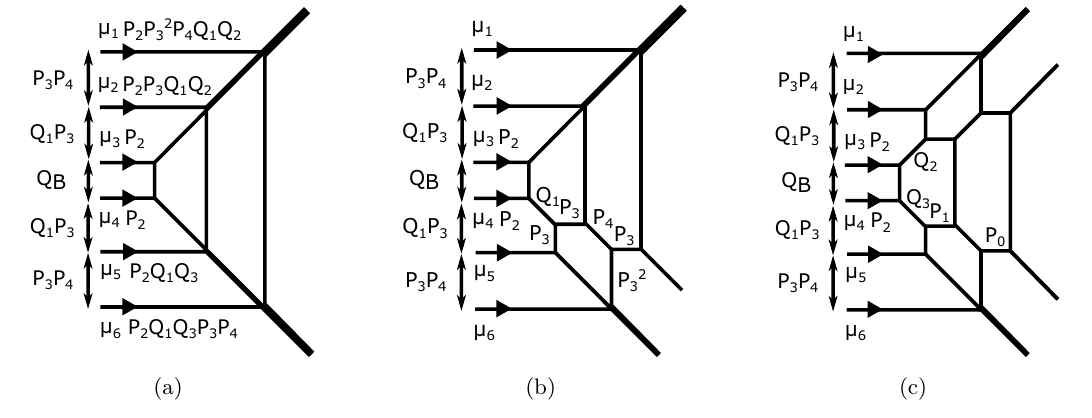
Figure 33. Parametrization of the web diagram for the geometry f (1)